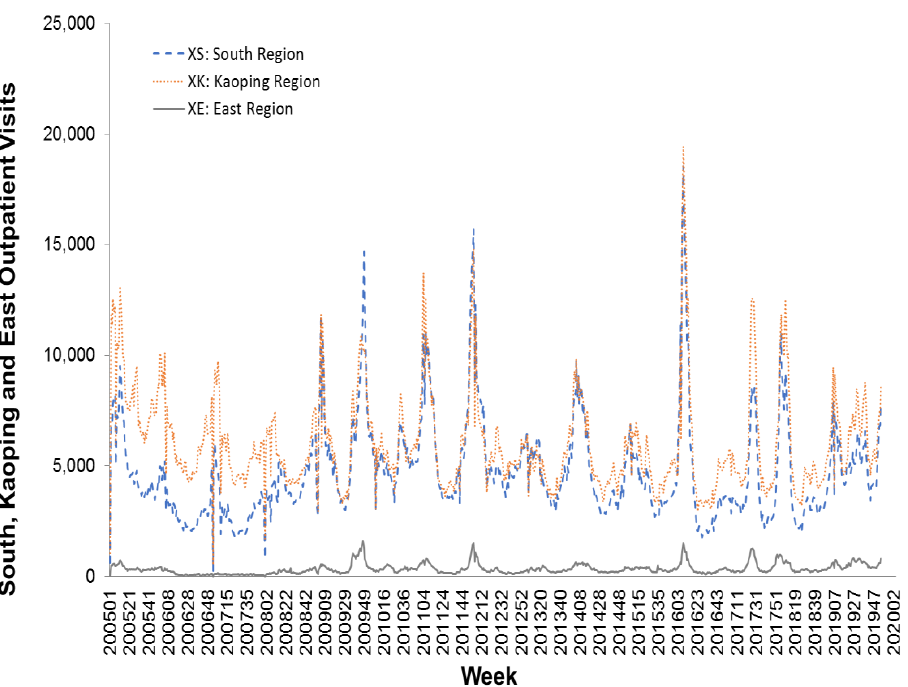
Figure 4. The influenza outpatient visits for South, East, and Kaoping regions in Taiwan from the first week of 2005 to the second week of 2020. Table 2. Forecasting results of one step (week) ahead outpatient